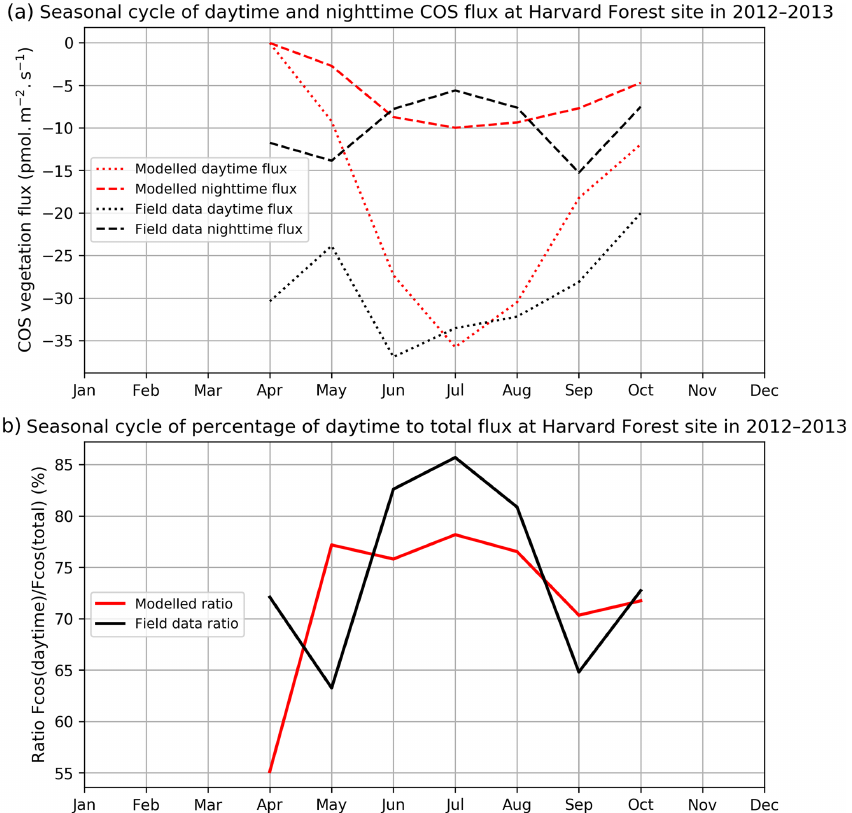
Figure 2. (a) Seasonal cycle of daytime (dotted curve) and nighttime (dashed curve) for observed (black) and modelled (red) vegetation COS fluxes. (b) Seasonal cycle of percentage of the daytime to the total flux (solid curve), at Harvard Forest in